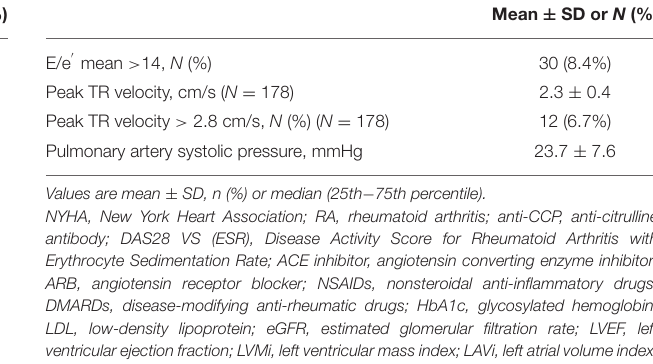
TABLE 1 | Baseline characteristics in the RA Porto cohort ( N =